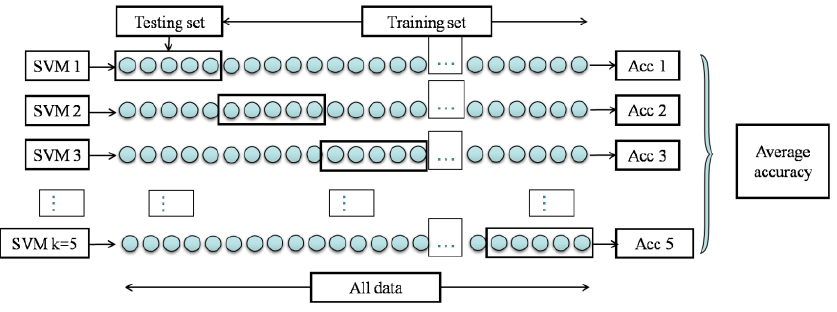
Figure 12. Diagram of k-fold cross-validation with k = 5.